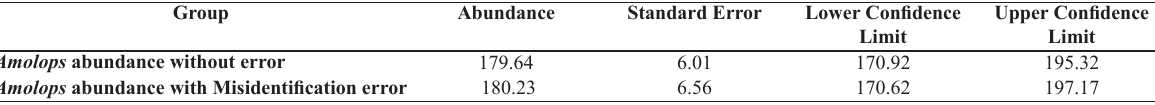
Table 3. Abundance estimation of Amolops formosus with identification error and without identification error.